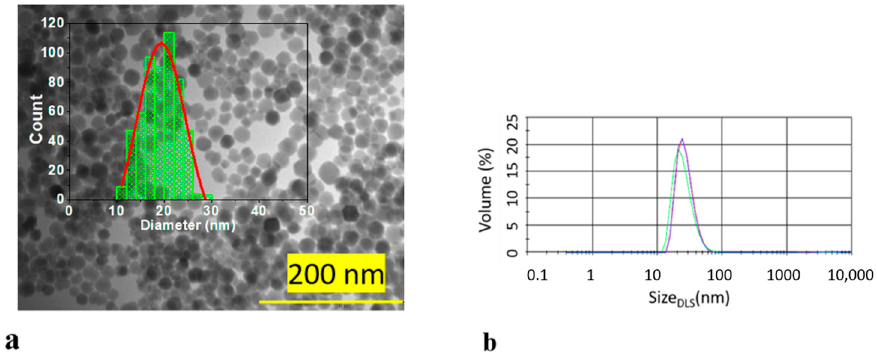
Figure 1. ( a ) Representative bright-field TEM image, together with the histogram of the size distribution (d TEM = 19.2 ± 3.6 nm). The solid red line represents the best Gaussian fit. ( b ) Dynamic light scattering (DLS) diameter d DLS measurements at pH 7.4. The green, blue and red lines represent data obtained from three different measurements.